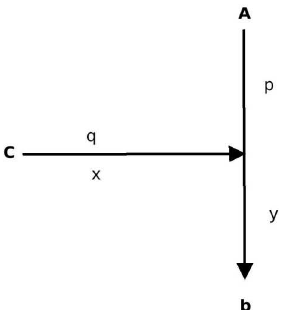
Figure 4. An argument for or against the inference link of another argument with strength x and polarity q ; A and C can have a complex argument structure and the inference from A to b can be of various structure